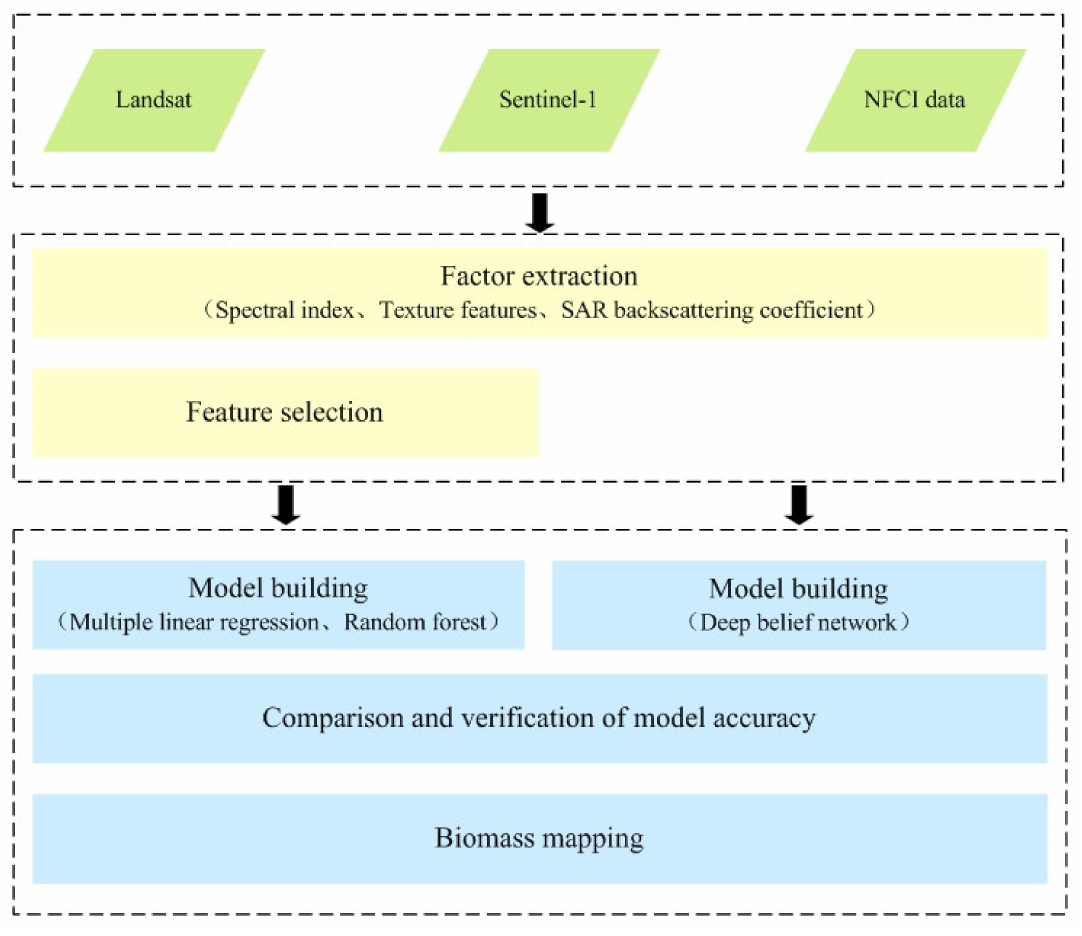
Figure 3. The technical workflow.